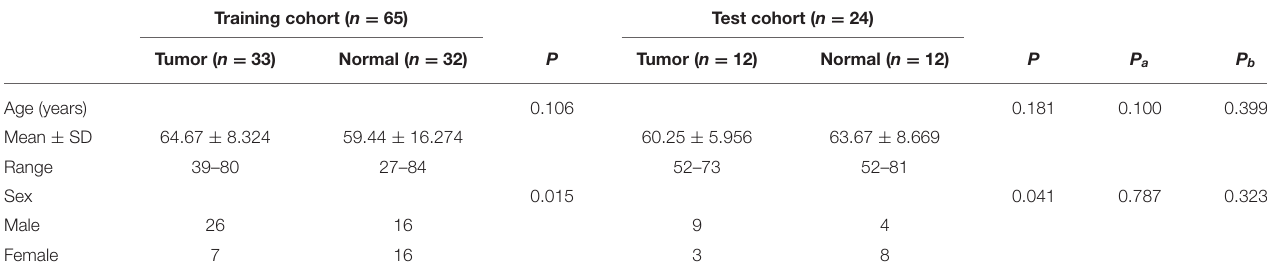
TABLE 1 | Clinical characteristics of patients in training and test groups.